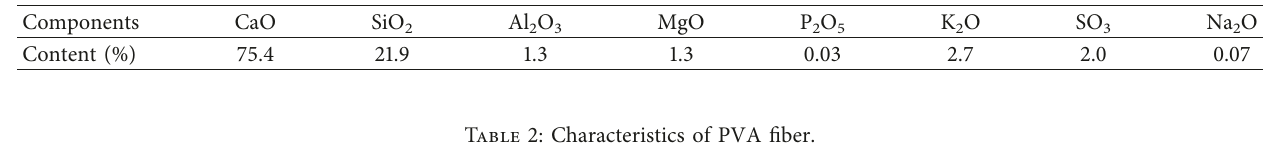
Table 1: The main chemical components of cement.